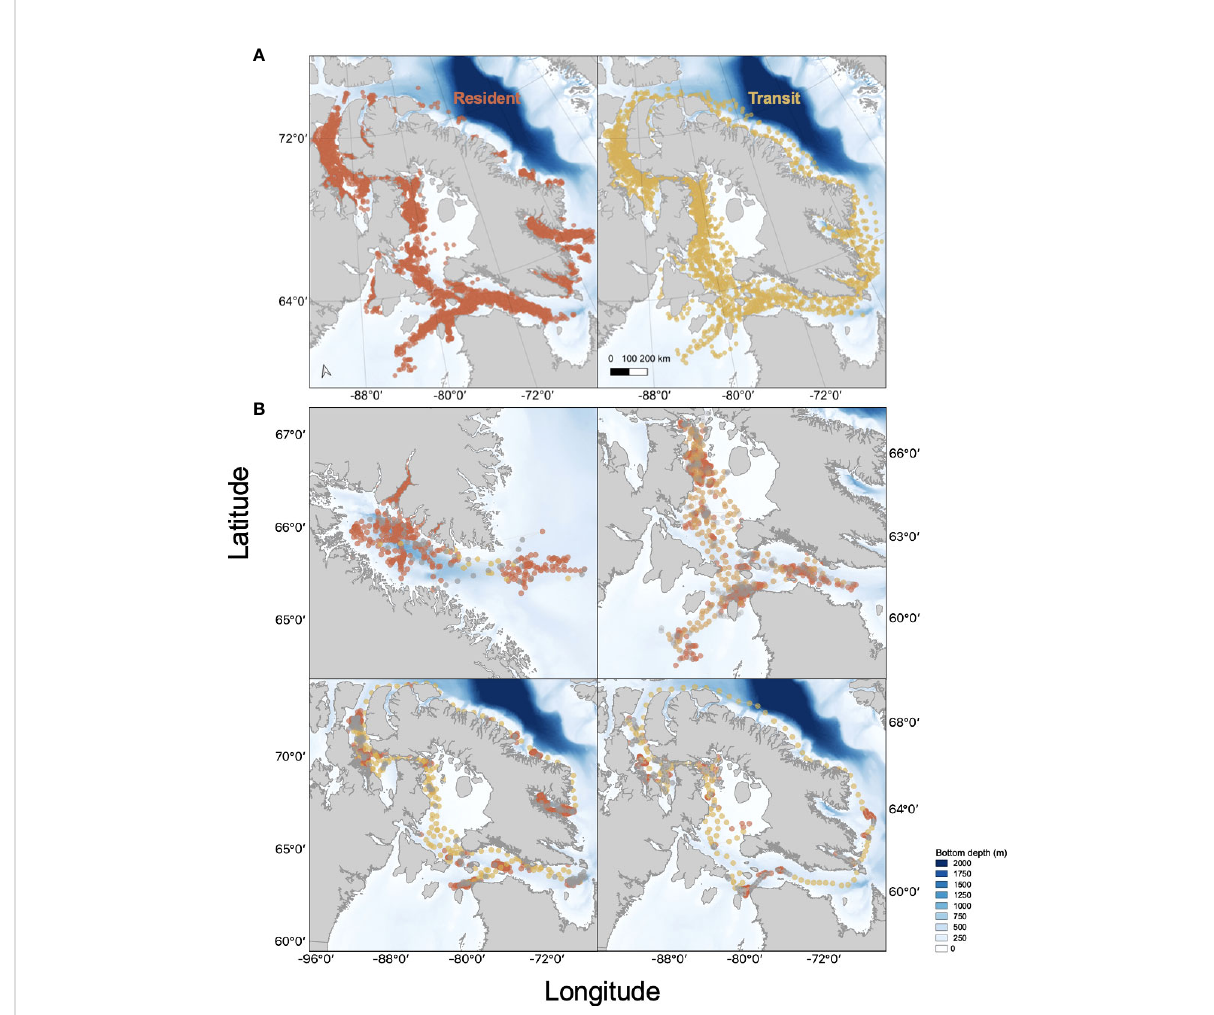
FIGURE 2 (A) : Argos Satellite locations for 25 SPLASH tagged bowhead whales in the Eastern Canadian Arctic derived from hierarchical switching state- space models (HSSSM). Resident ( ● ) and transit ( ● ) behavioural states derived from the HSSSM are plotted for each animal. (B) : Example of Argos satellite tracks derived from HSSSM predictions for four SPLASH tagged bowhead whales (PTT 114504, 128150, 128152, 128153) resident, transit and unknown ( ● ) behavioural states highlighted behavioural states derived from the HSSSM are shown for each